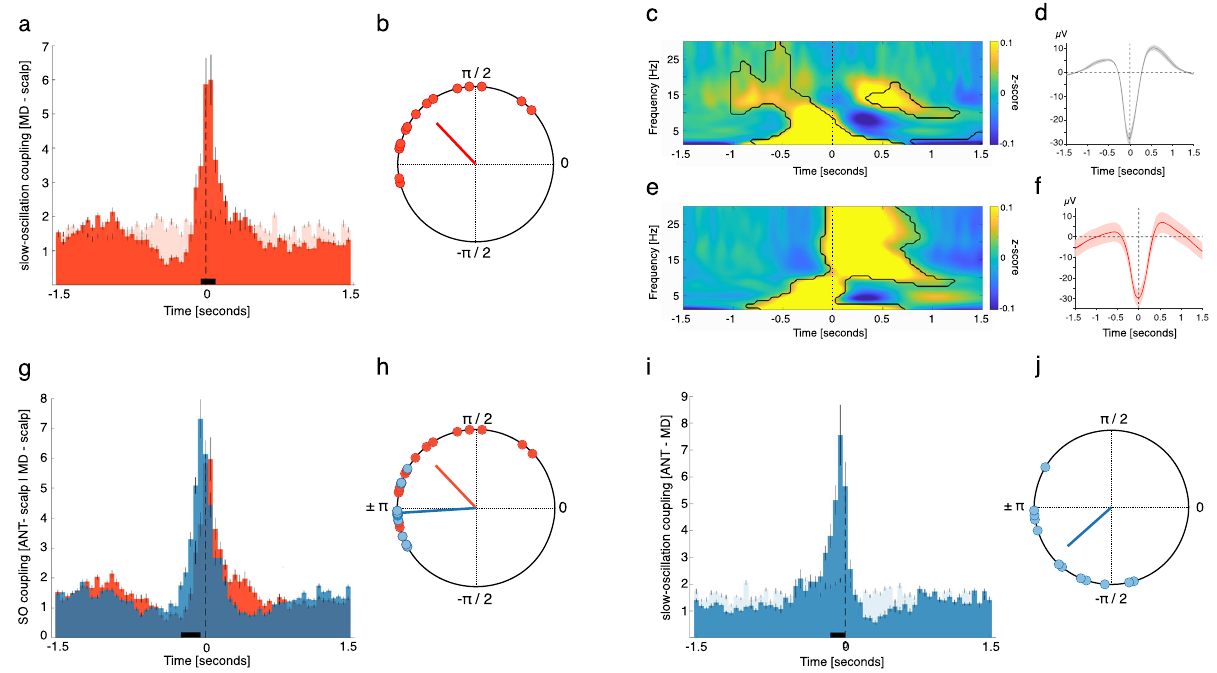
Fig. 3 | Neocortical SOs precede MD SOs. a Occurrence probabilities of MD relative to neocortical SO down-states (time=0, dashed line; bin size = 50ms). On average, neocortical SOs lead MD SOs. The solid black line indicates signi fi cant differences, compared to SO-free events (dependent-samples t -test, two-sided, cluster: − 0.05 to 0.1s, p =0.021; peak time: 0.05s, corrected across time). b Phase of MD SOs during neocortical down-states for paired events. MD SO phases fol- lowed neocortical counterparts (± π indicates phase of neocortical down-states; mean coupling direction: 133.51±10.91°; Rayleigh test, one-sided: p <0.0001; z =7.94). c Time – frequency representation (TFR) of neocortical SOs (locked to down-states), contrasted against event-free segments. Contour lines indicate clusters (two-sided dependent-samples t -test, p <0.05, corrected across time and frequency). d Grand average of neocortical SOs (mean±SEM, negative peak, time 0, N =1543.4±114.9). e TFR of all MD SOs (locked to down-states), contrasted againstevent-freesegments.Contourlinesindicateclusters(two-sideddependent-